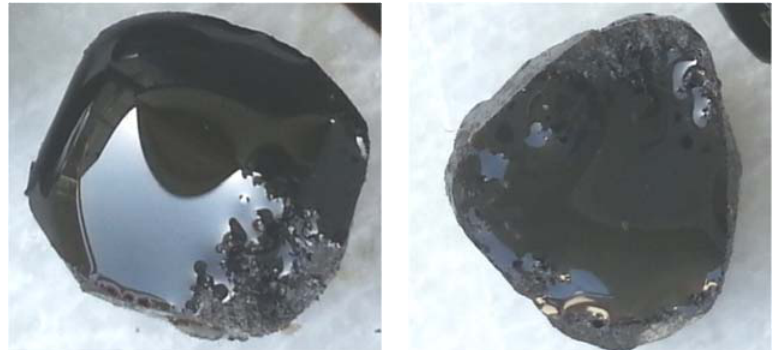
Figure 5: A bisected capsule between 3 and 4 mm